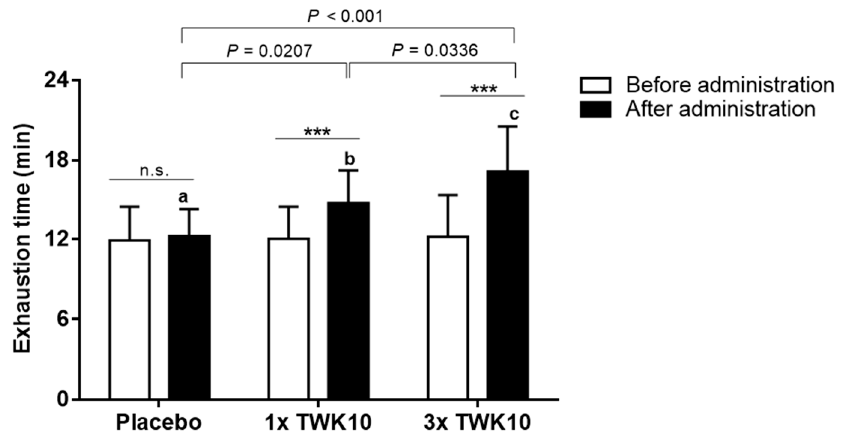
Figure 2. TWK10 improved exercise endurance performance in a dose-dependent manner.